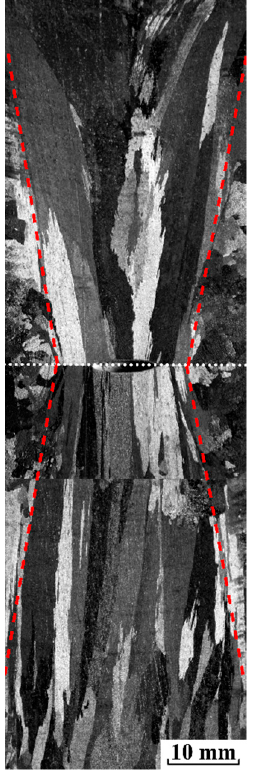
Figure 2. The longitudinal as-cast macrostructure of pure aluminum ingot without electropulsing.